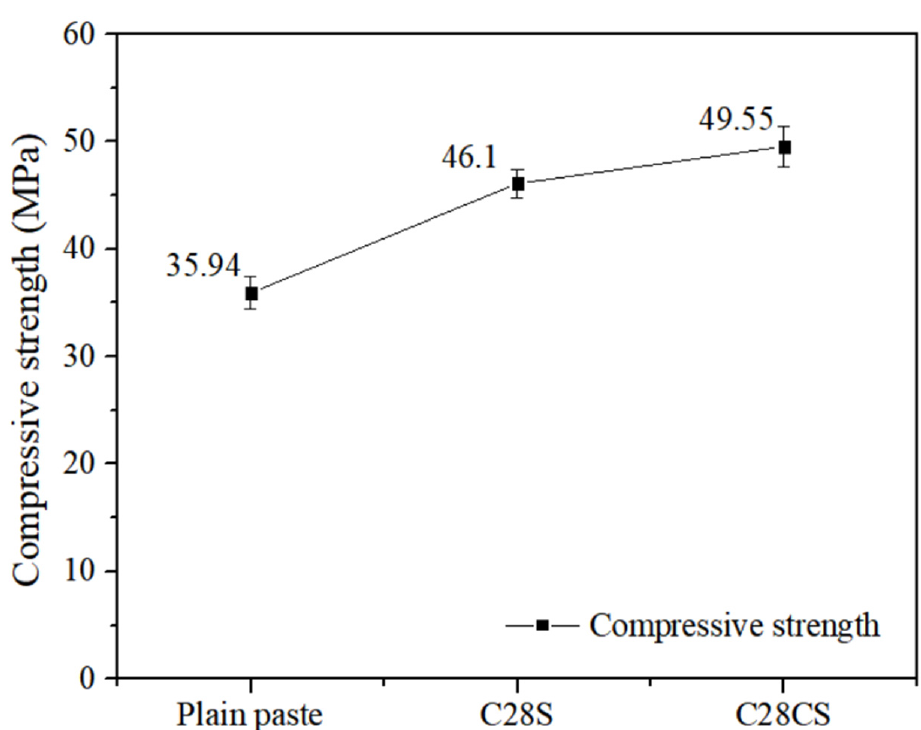
Figure 4. Results from compressive strength test.